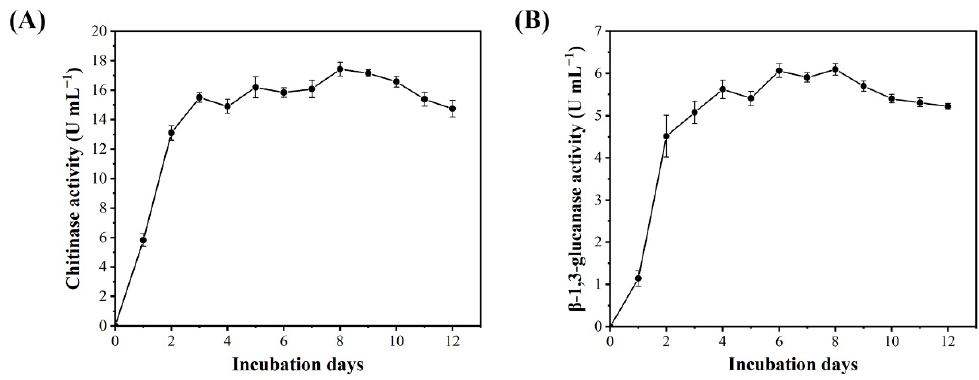
Figure 3. Dynamics in the activities of chitinase ( A ) and β -1,3-glucanase ( B ) in SS of BQ-33 within 12 days.